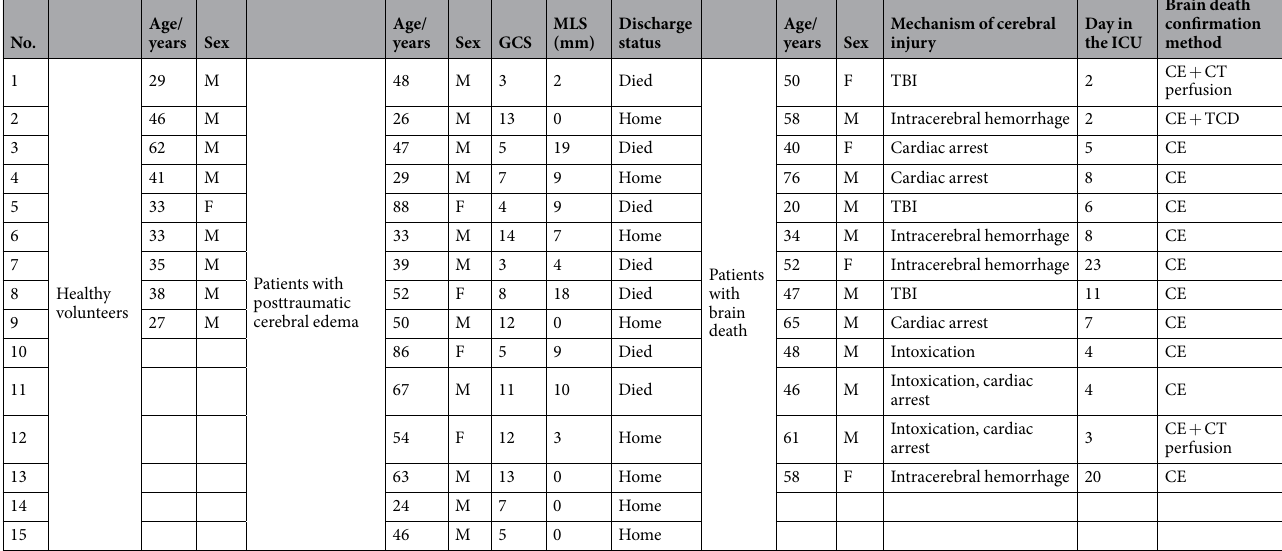
the concentrations of these chromophores are indicative of the oxygenation level of the blood passing through the brain, and can be monitored using near-infrared spectroscopy (NIRS). Until now, a few NIRS studies assess- ing cerebral oximetry as an indicator of cerebral blood flow (CBF) have been performed for confirmation of brain death 18,19 . Regional cerebral tissue oxygen saturation (rSO 2 ), which is typically estimated in NIRS studies, depends on oxygen saturation of arterial and venous blood, as well as the composition of the volumes of the arte- rial, venous, and capillary vascular compartments. The relationship between rSO 2 and CBF is complex, especially when cerebral metabolism is no longer maintained. There are additional factors influencing rSO 2 in patients with brain death when residual CBF is preserved or when steal phenomena of blood from extracerebral tissues to cortex capillaries is present 20 . Furthermore, NIRS has the disadvantage of the unreliable separation of informa- tion from intracerebral tissue and extracerebral contamination 21 . Consequently, measurements of rSO 2 have not proven useful for the confirmation of brain death, as the values of cerebral oximetry in some cases remain within the normal range even when cessation of CBF is confirmed 18,19,22 . A potential new method for the determination of CBF appeared with the application of optical methods and bolus-tracking techniques using indocyanine green (ICG) as an intravascular flow tracer. It was shown that ICG concentration changes can be monitored during its circulation through the brain, and several algorithms have been used to assess CBF 23–25 . It was reported that time-resolved NIRS (TR-NIRS) can be utilized to track ICG with improved depth discrimination 26,27 . TR-NIRS is based on the emission of short laser light pulses into the tis- sue and the analysis of the distributions of times of flight of photons reemitted from the tissue. The method allows for selective analysis of the late photons, which have a higher probability of penetrating the cerebral cortex. This